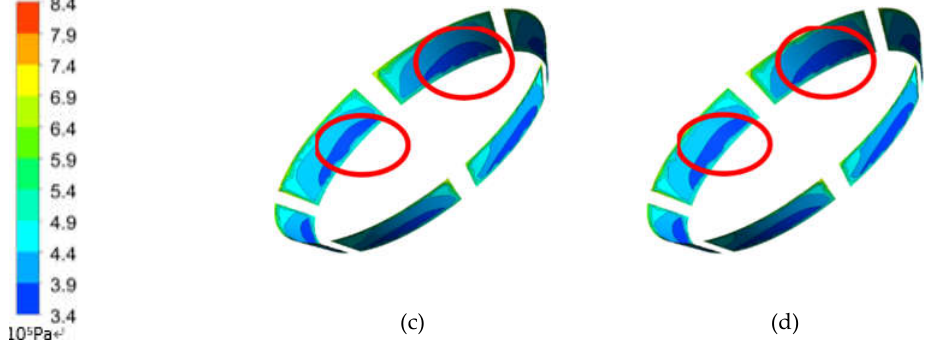
Figure 12. Pressure contour at second-stage impeller outlet, ( a ) 0.3 mm, ( b ) 0. 6mm, ( c ) 0.9 mm, ( d ) 1.2 mm.